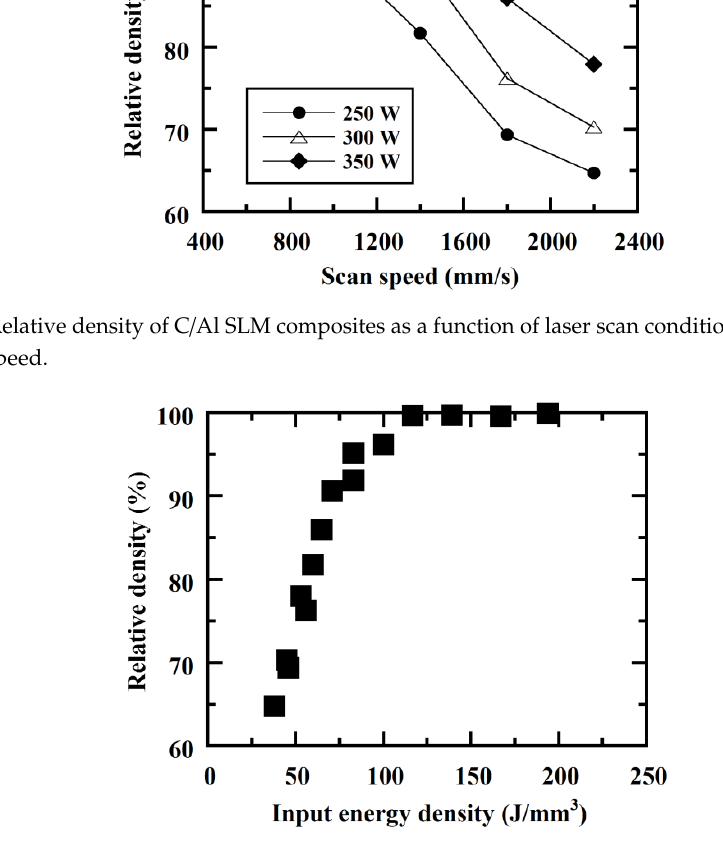
Figure 5. Relative density of C/Al SLM composites as a function of energy density.